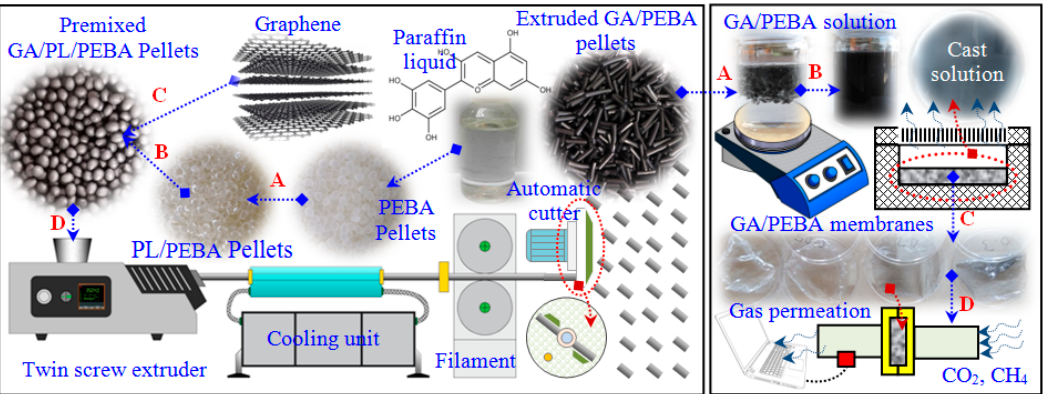
Figure 1. GA / PEBA membranes’ fabrication flowchart based on the developed